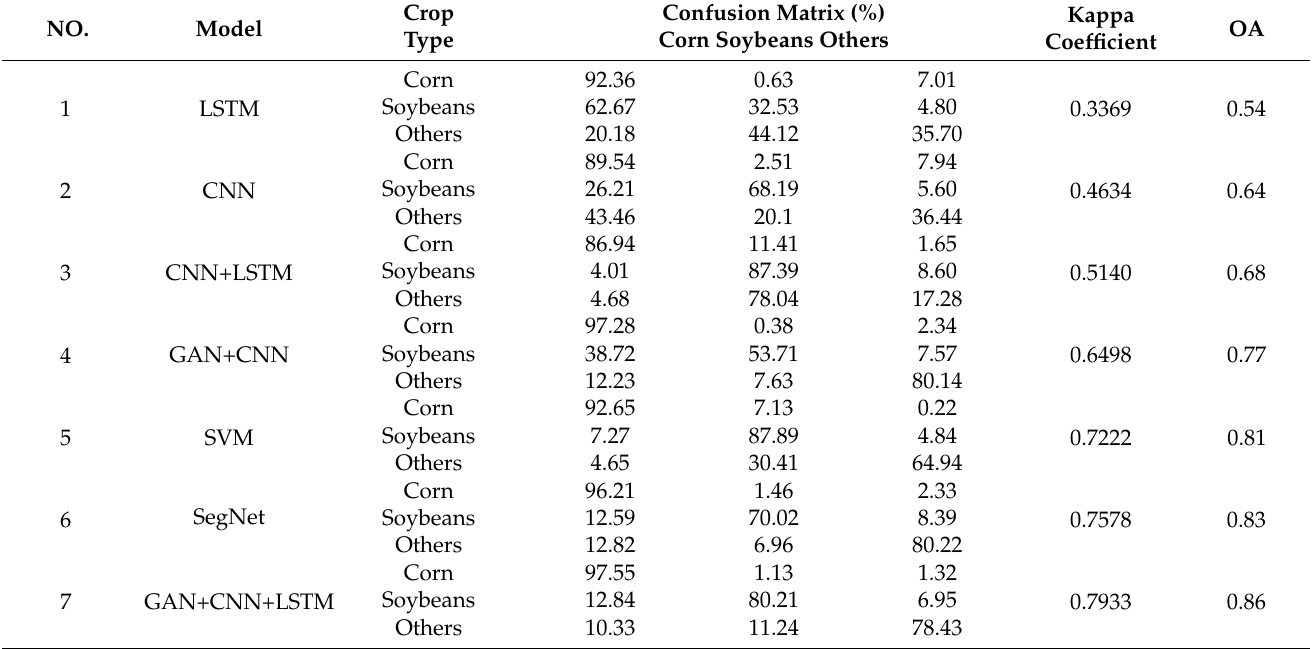
Table 2. Classification accuracy of seven different models on multi-temporal and multi-band data sets.